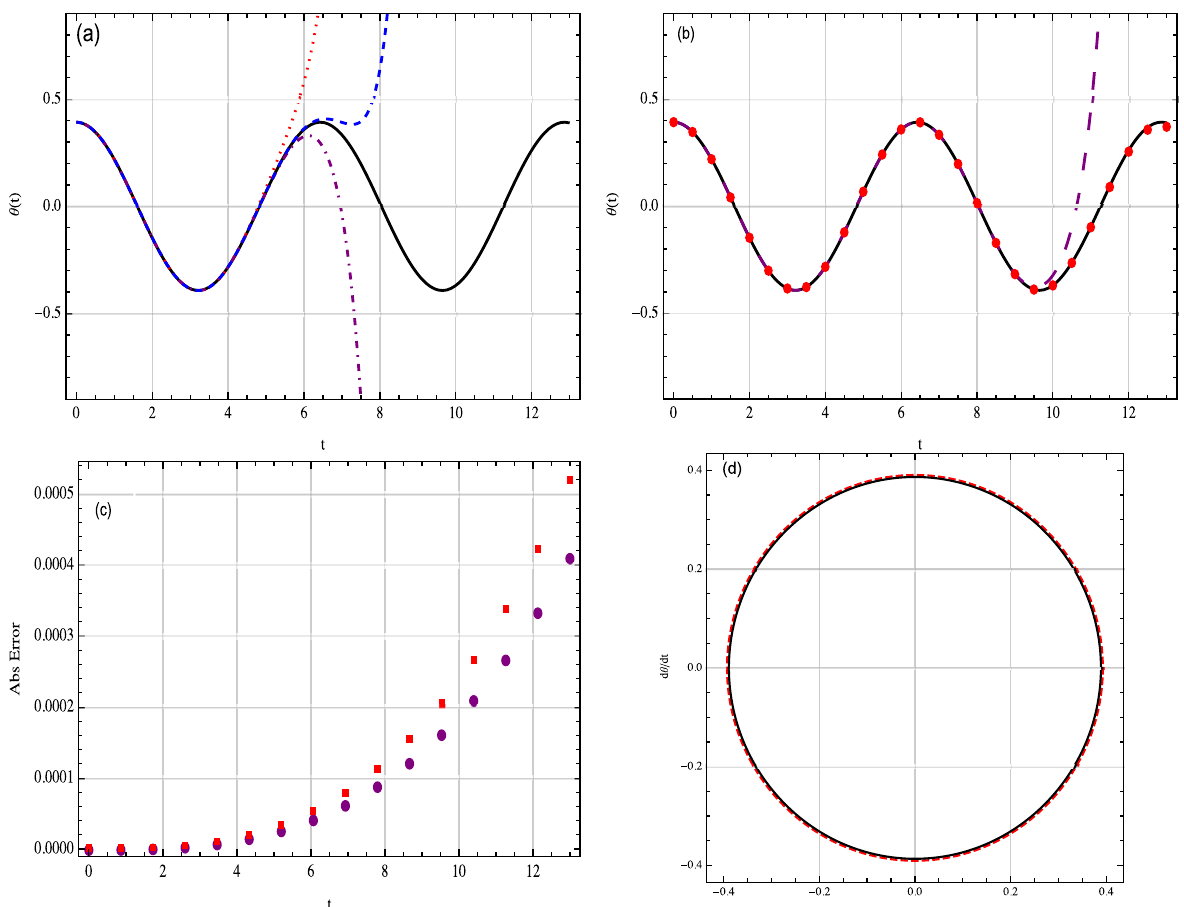
Figure 1: ( a ) Comparison of the MDM approximation θ t π , 0, 8, 0 10 ( ) / ( dotted line ) , θ t π , 0, 8, 0 14 ( ) / ( dash - dotted line ) , θ t π , 0, 8, 0 16 ( ) / ( dashed line ) and the exact solution ( solid line ) . ( b ) The exact solution ( solid line ) , the 20th - order MDM numeric solution θ h 0.25 = ( dashed line ) , and the 25th - order MDM numeric solution θ 25 ⟨ ⟩ with the exact solution ( dots ) and the 25th - order ADM numeric solution ( squares ) , respectively. ( d ) Phase plane diagram, exact ( solid θ k 25 ⟨ ⟩ approximation ( dashed line ) for Example line ) , and θ k